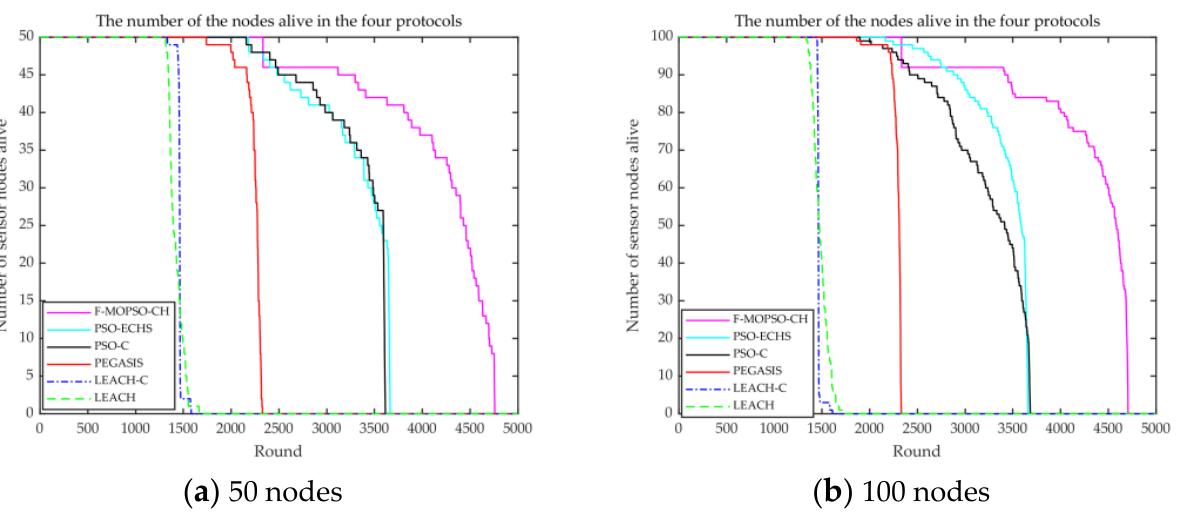
Figure 8. The Pareto solutions. Table 2. The boundary conditions of network.